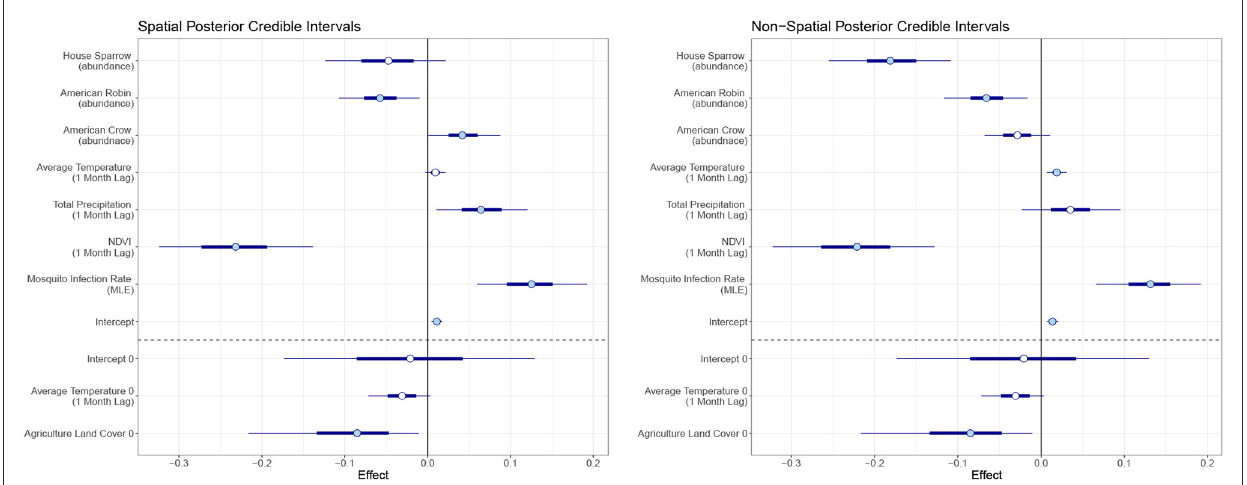
FIGURE4 Posterior credible intervals of the effect of each covariate for the spatiotemporal and temporal model. The skinny outer line indicates the 95% credible interval, the thick line is the 50% credible interval, and the circlular point is the median. A filled circle indicates the covariate is significant at the 95% level.